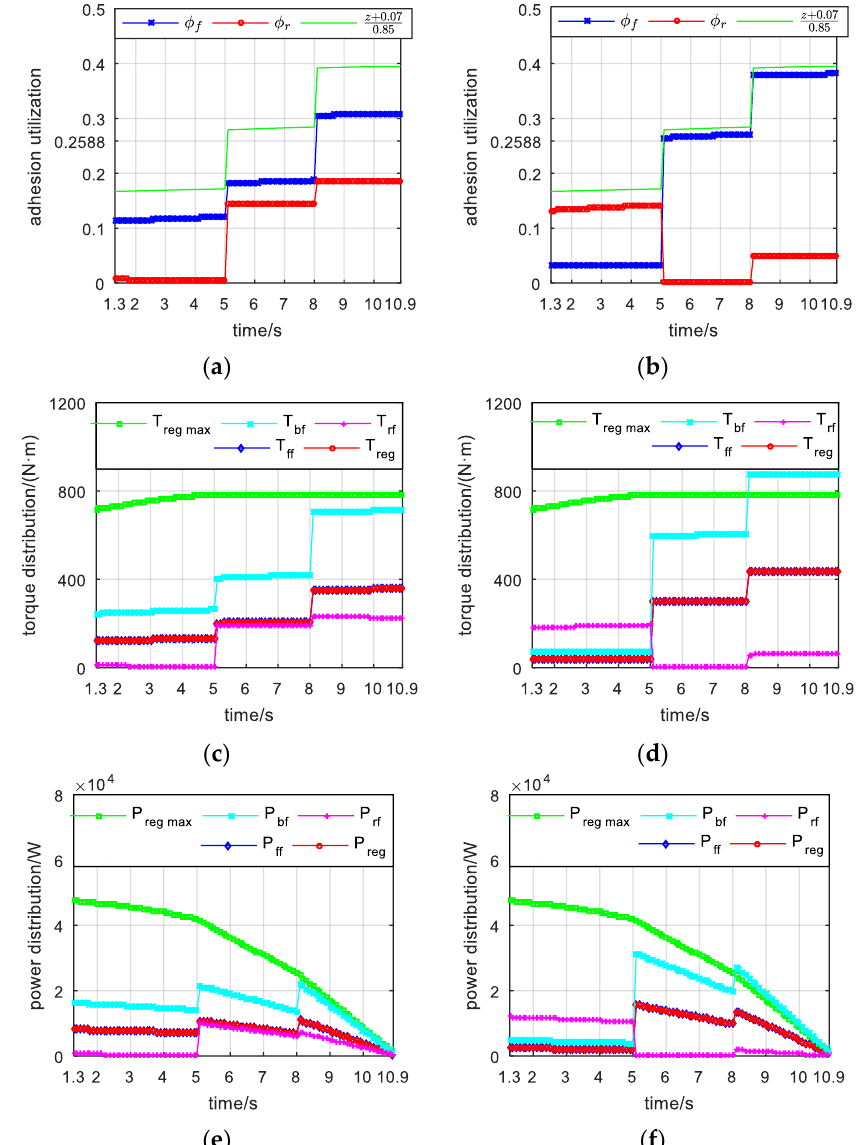
Figure 5. Braking performance of RNN-NOPS and EPNN in terms of adhesion utilization in ( a , b ), respectively; torque allocation in ( c , d ), respectively; power allocation in ( e , f ), respectively. (i) Adhesion utilization results of RNN-NOPS and EPNN are shown in Figure 5a,b, respectively. When z = 0.1, ( z + 0.07 ) /0.85 = 0.2; when z = 0.15, ( z + 0.07 ) /0.85 is about 0.2588. Then from Equation (20), given ( z + 0.07 ) /0.85 < 0.2588, c 5 ( x ) is not involved